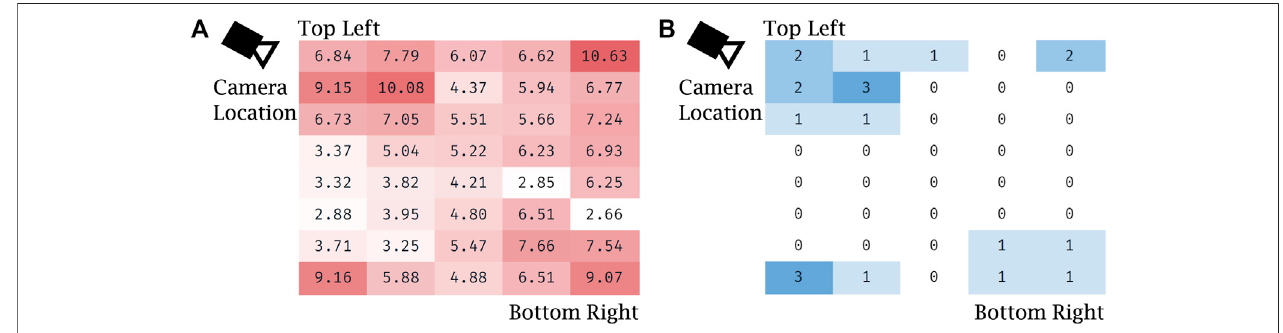
FIGURE 8 | Evaluation of robot positioning accuracy with visual servoing: (A) heat map of Euclidean error (in mm) for visual servoing for each of the 40 locations spanning the screen, averaged over the fi ve trials, (B) heat map of the number of outliers with respect to Euclidean error for each of the same locations spanning the screen, summed over the fi ve